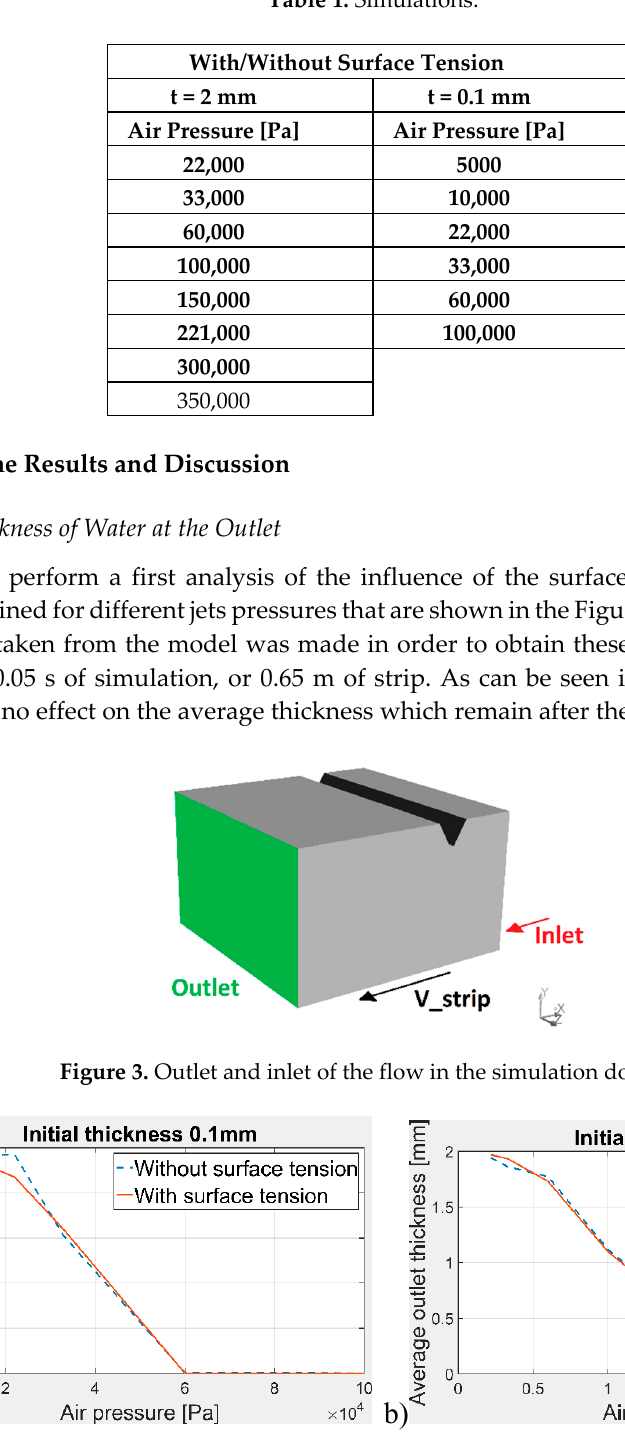
Figure 4. Average thickness at the outlet for initial thickness 0.01 ( a ) mm and 2 mm